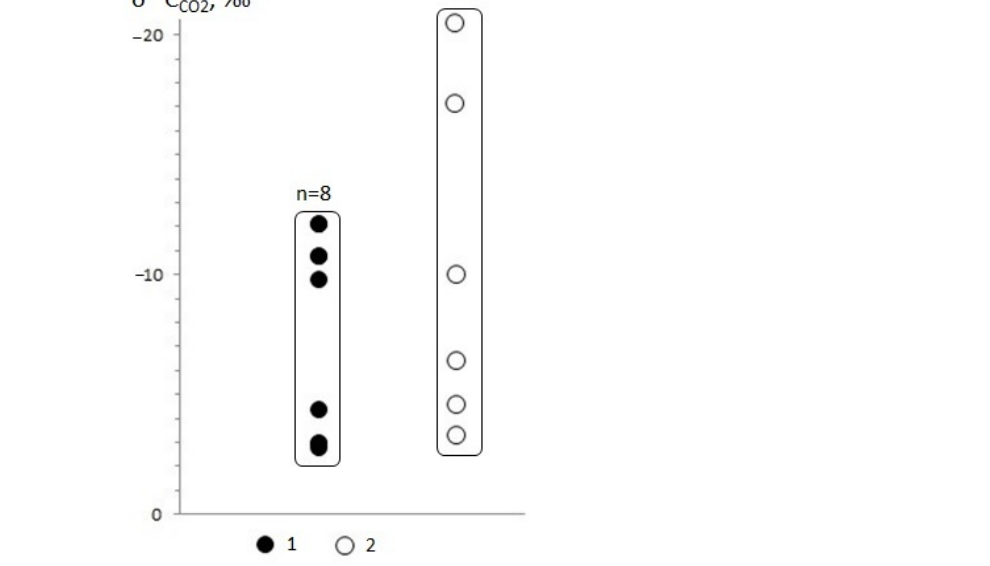
Figure 5. Carbon isotope composition ( δ 13 C CO2 , ‰) of carbon-containing compounds of fluid inclusions in gold-bearing (1) and barren (2) quartz from the Blagodatnoye gold deposit. Isotopes of helium. In fluid inclusions in quartz from ore body No.2 (sample 100/216.5, with gold content 10.2 g/t) 3 He and 4 He isotopes of helium were detected. The contents of 3 He and 4 He are 0.12 · 10 − 12 and 0.85 · 10 − 6 cm 3 /g, respectively. The 3 He/ 4 He ratio is 0.14 ± 0.3 × 10 − 6